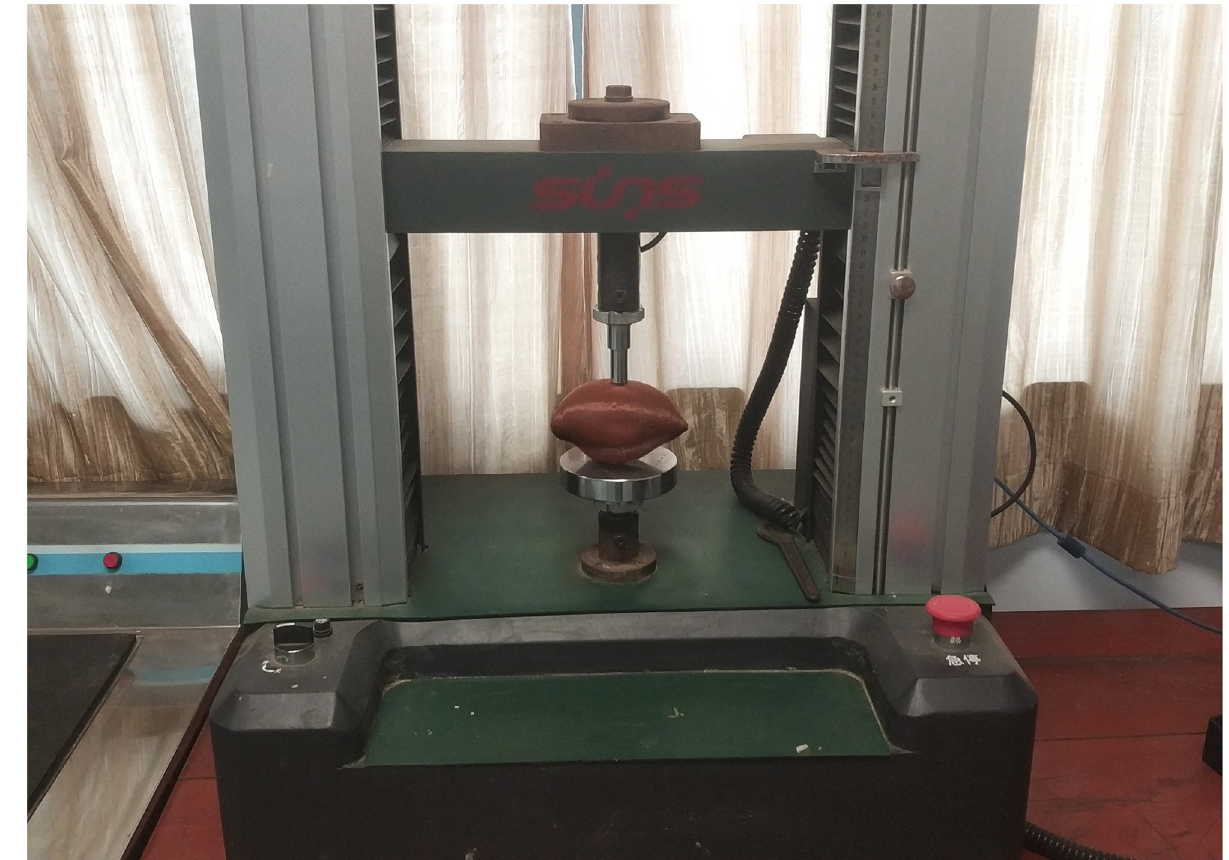
Fig 1. DWD type electronic universal testing